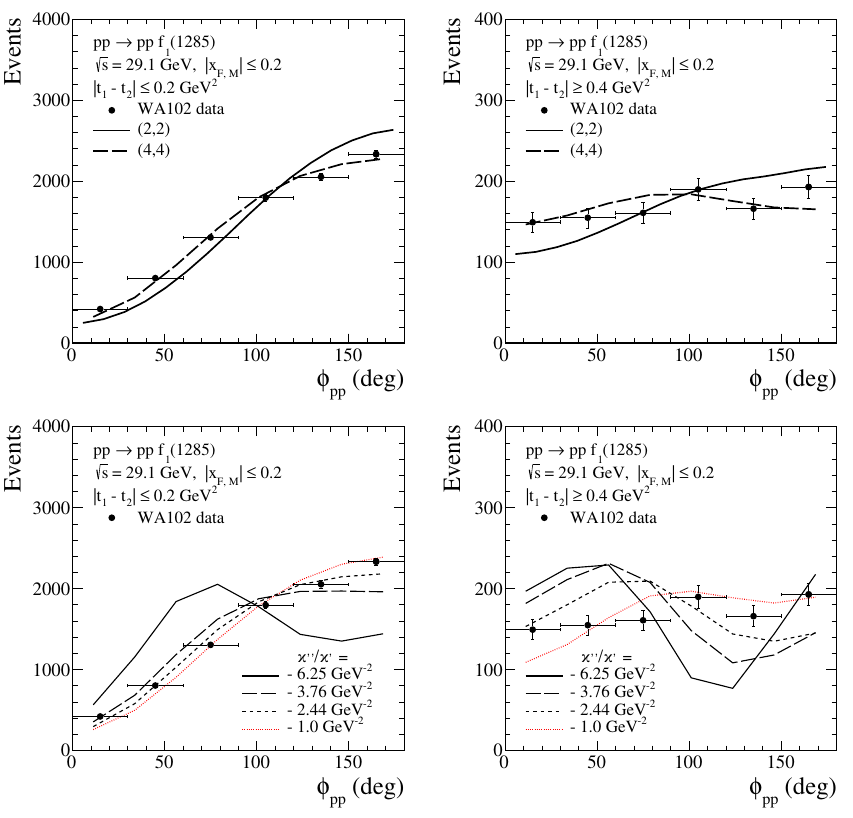
(cid:112) s = 29.1 GeV, − t | (cid:190) 0.4 GeV 2 1 2